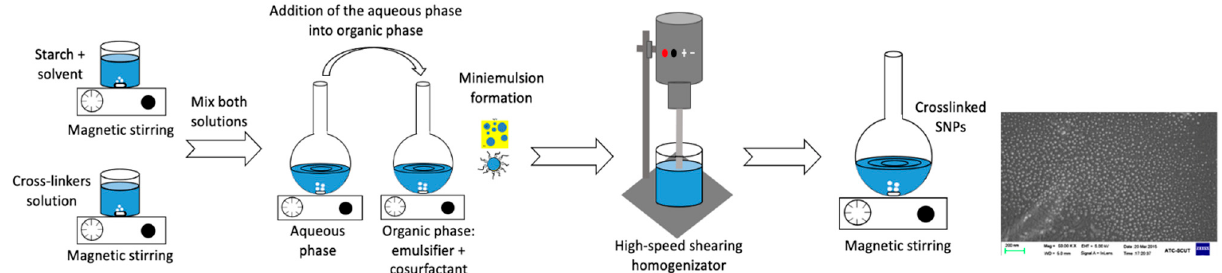
Figure 4. Synthesis of SNPs through emulsion cross-linking method and SEM micrograph of SNPs. Reprinted from [34] with permission from Elsevier. Copyright (2016).